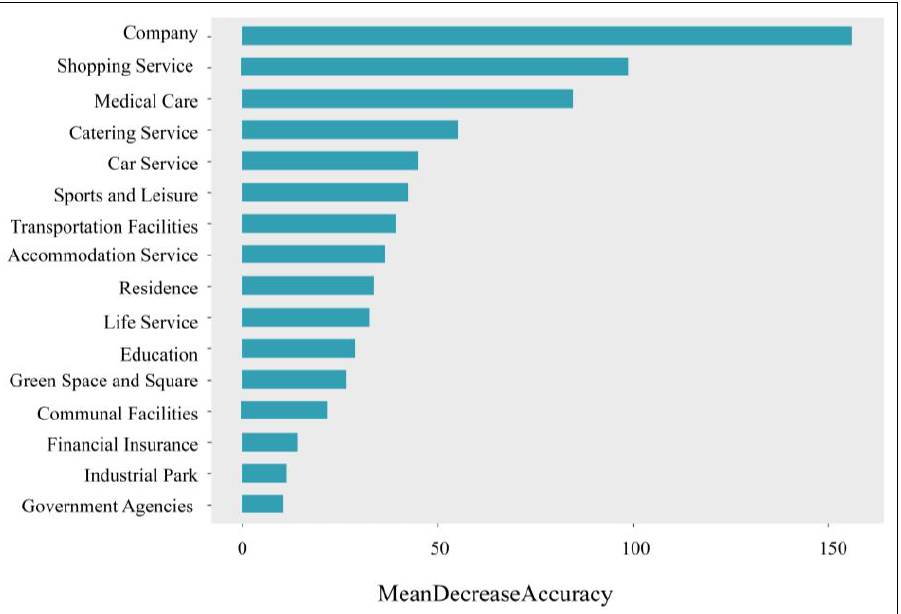
Figure 3. The importance ranking of influencing factors.